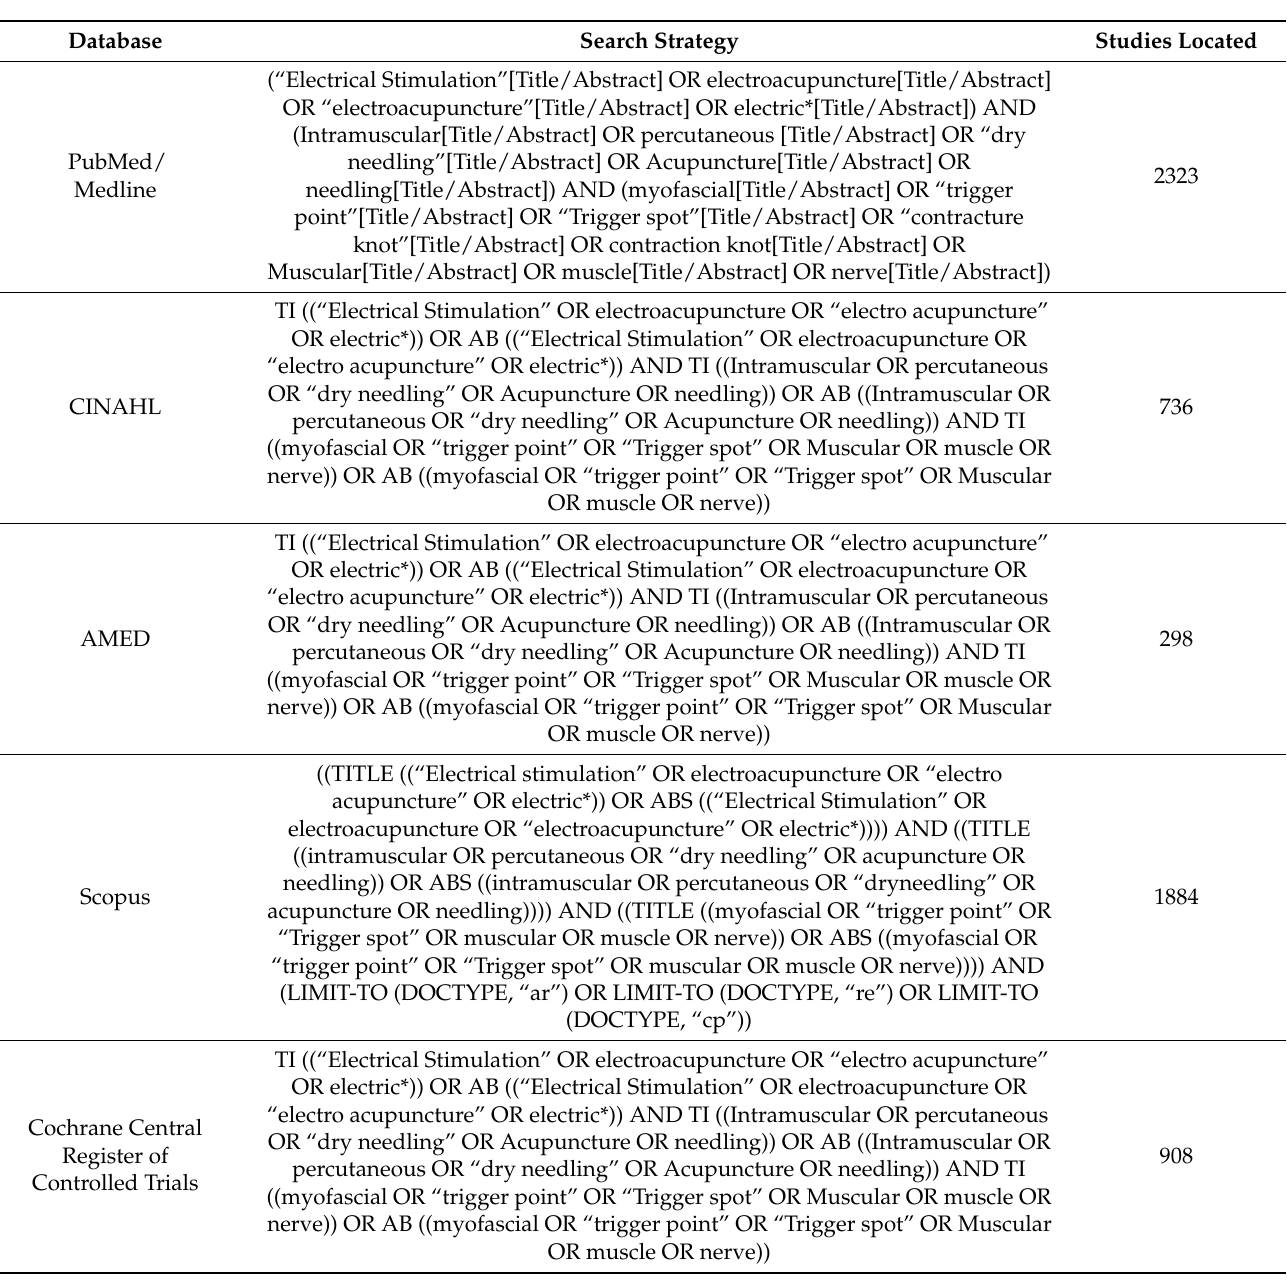
Table 1. Database formulas during literature